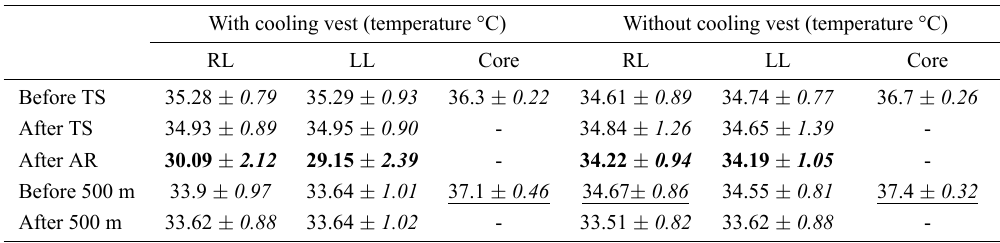
Fig. 2. Infrared thermograms along the protocol – example of two sequences of thermographic images collected in different moments of the protocol, with and without the cooling vest. (a) Without cooling vest. (b) With cooling vest. TS, training session; AR, active recovery. Table 1. Skin temperature above the right (RL) and left (LL) latissimus dorsi muscle (ROI) and the core temperature registered during the protocol (before and after the training session, after the active recovery and before and after the 500 m test) for the two active AR conditions. With cooling vest (temperature °C) Without cooling vest (temperature